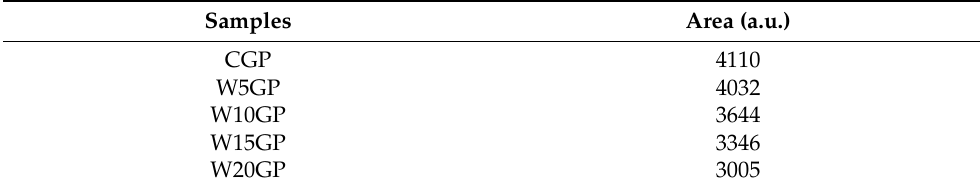
Table 3. Hump area under the peak between 20 ◦ and 37 ◦ 2 θ